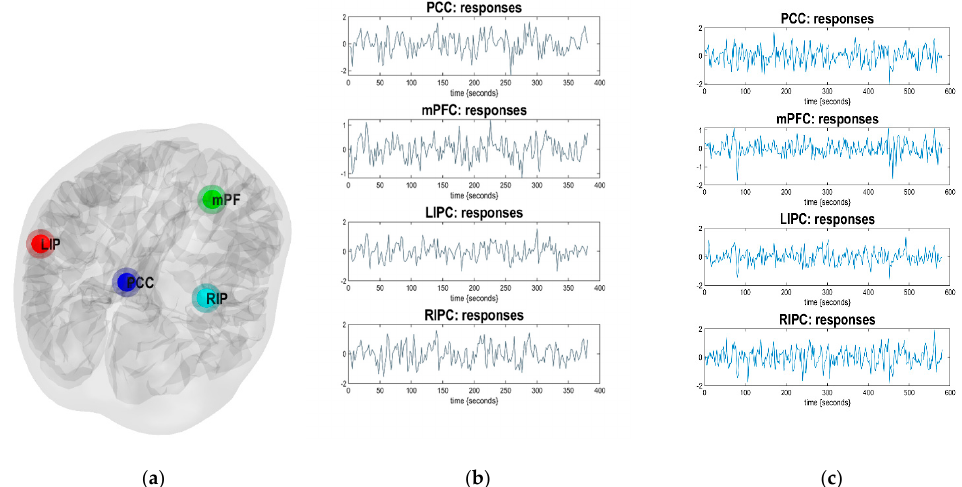
Figure 2. ( a ) The locations of the DMN regions (PCC, mPFC, LIPC and RIPC) on a 3-D brain image and ( b , c ) the low-frequency fluctuations (LFF) obtained from the DMN regions for scan durations of 10 min and 15 min. The time series (right-hand panels) from four regions are the principal eigenvariates of regions identified using seed connectivity analyses for a single subject. These time series we used to invert the spectral DCM with the (fully-connected) architecture.